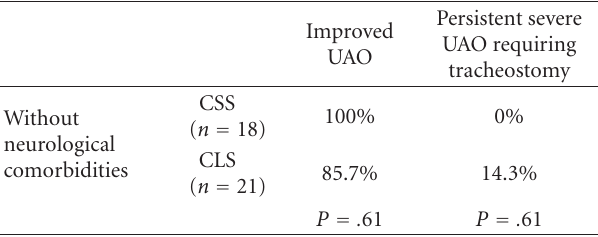
Table 3: Postoperative Relief of Upper Airway Obstruction: CSS versus